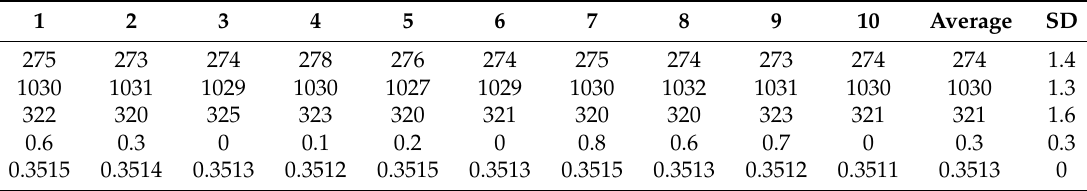
Table 2. The average and standard deviation.